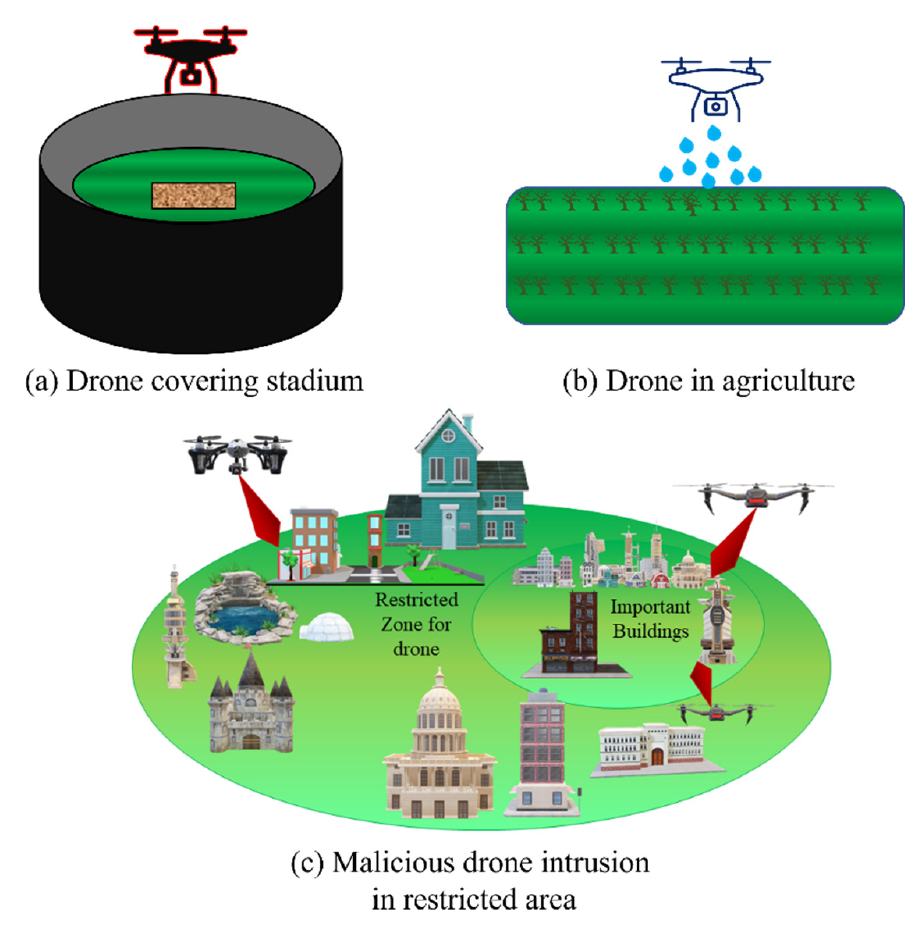
Figure 1. ( a , b ) Normal use cases of drones; ( c ) malicious drone intrusion in the restricted areas.